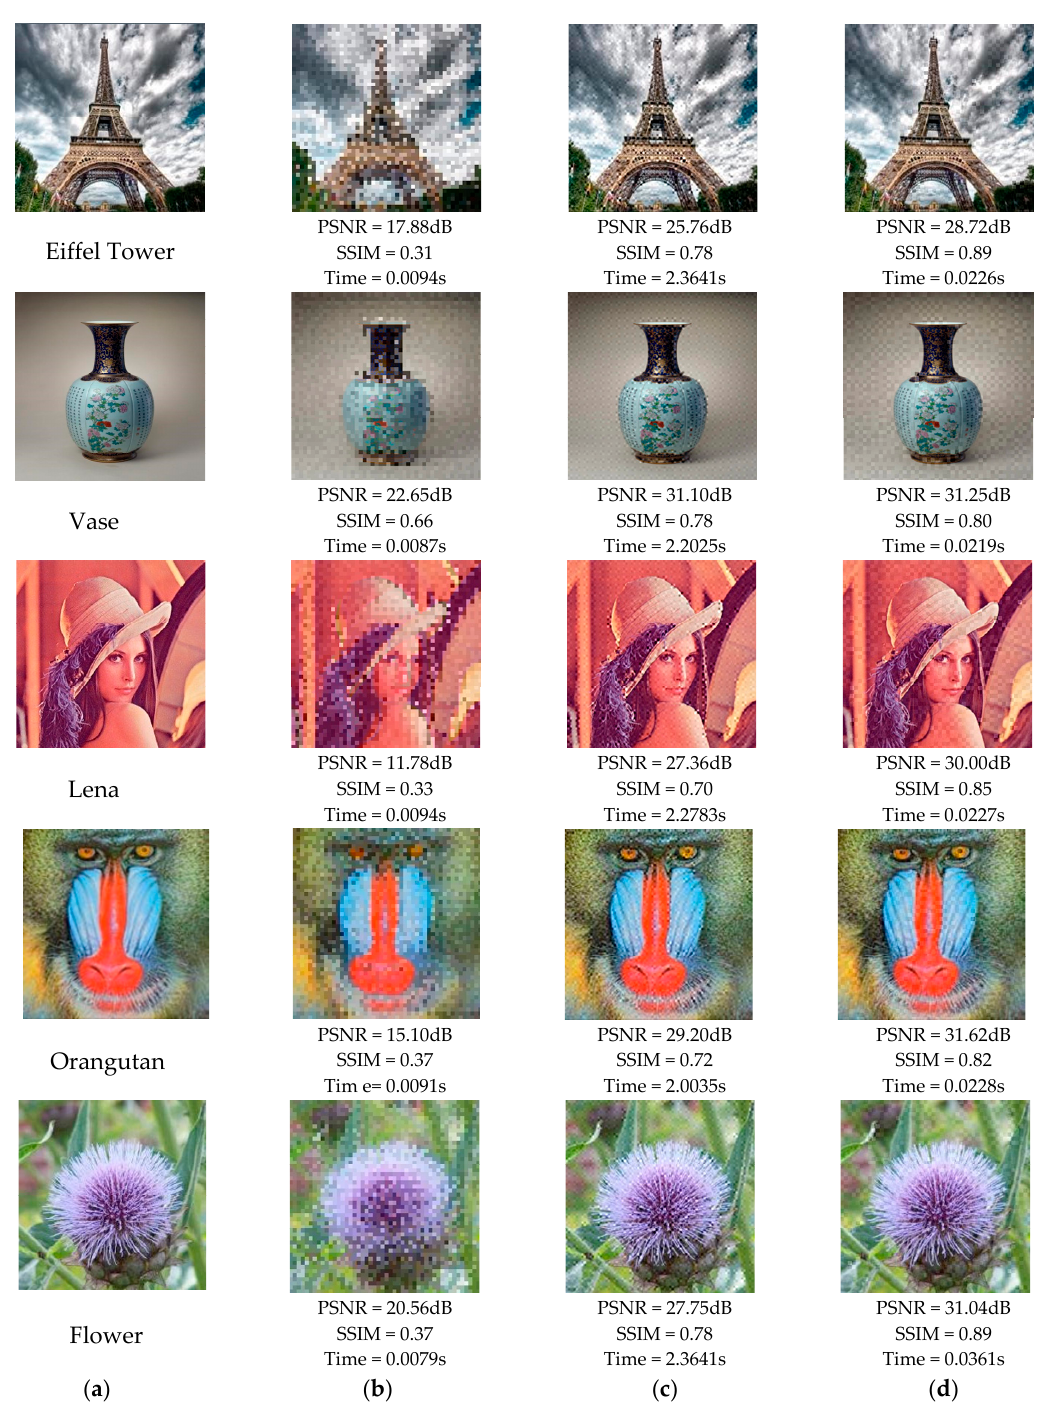
Figure 8. The perceptual quality and encoding time comparisons of different aesthetic 2D barcodes. ( a ) Carrier images, ( b ) SRA codes [28] with threshold δ = 10, ( c ) RA codes [31] with threshold δ = 10, and ( d ) our codes with threshold δ= 10 .